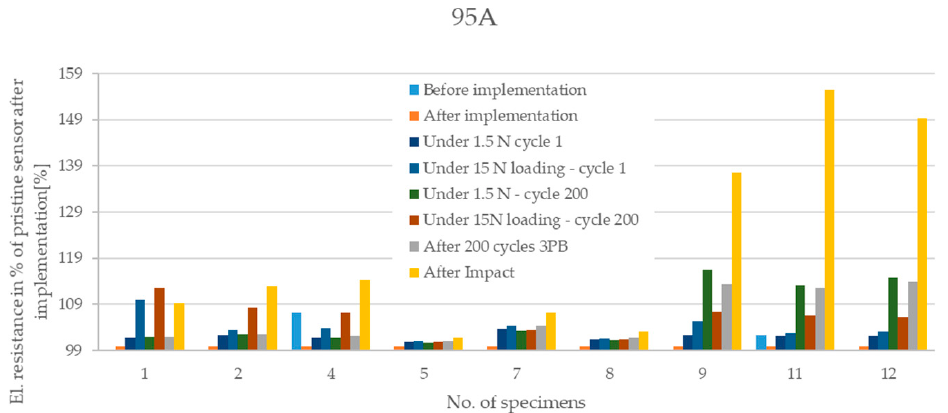
Figure 11. Electrical resistance of integrated sensors as a percentage of the value of a pristine sensor after implementation-results for specimens with CFSs made of material 95 A.